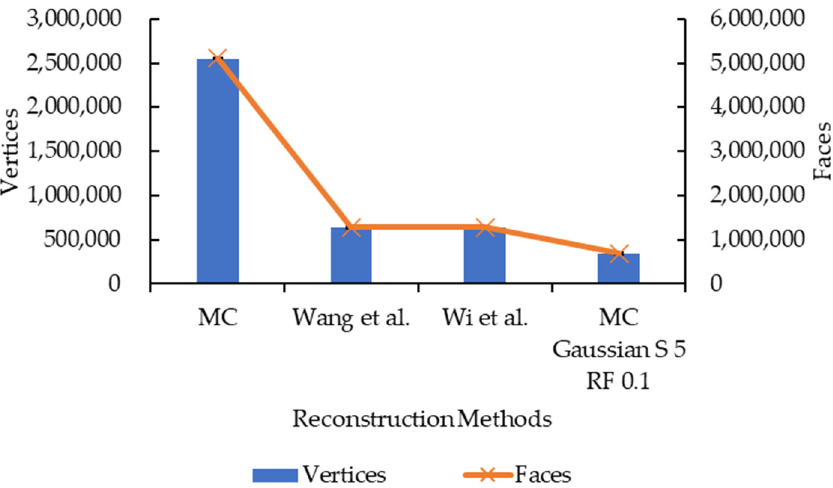
Figure 21. Graph of number of vertices and faces against different reconstruction methods.